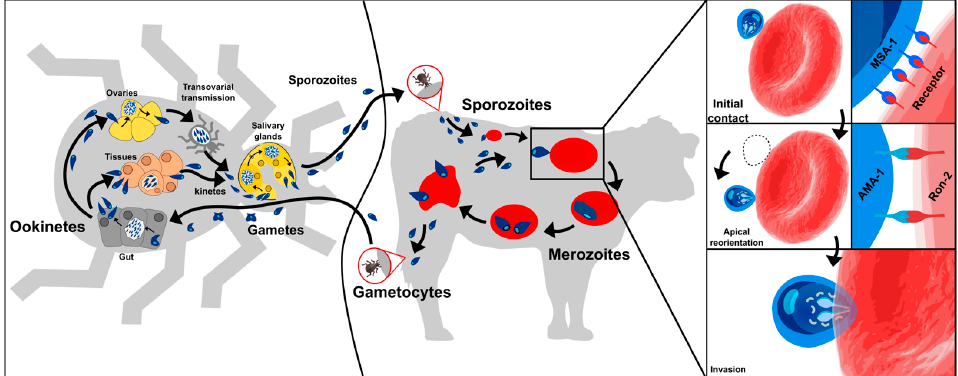
Figure 1. B. bovis life-cycle. Two hosts are involved; one is a vector (tick) in which the sexual part of its cycle takes place (left) and the other a vertebrate host (bovine) where asexual multiplication takes place (middle). Right panel shows proteins identified so far as participating in parasite initial contact and reorientation towards the apical pole.